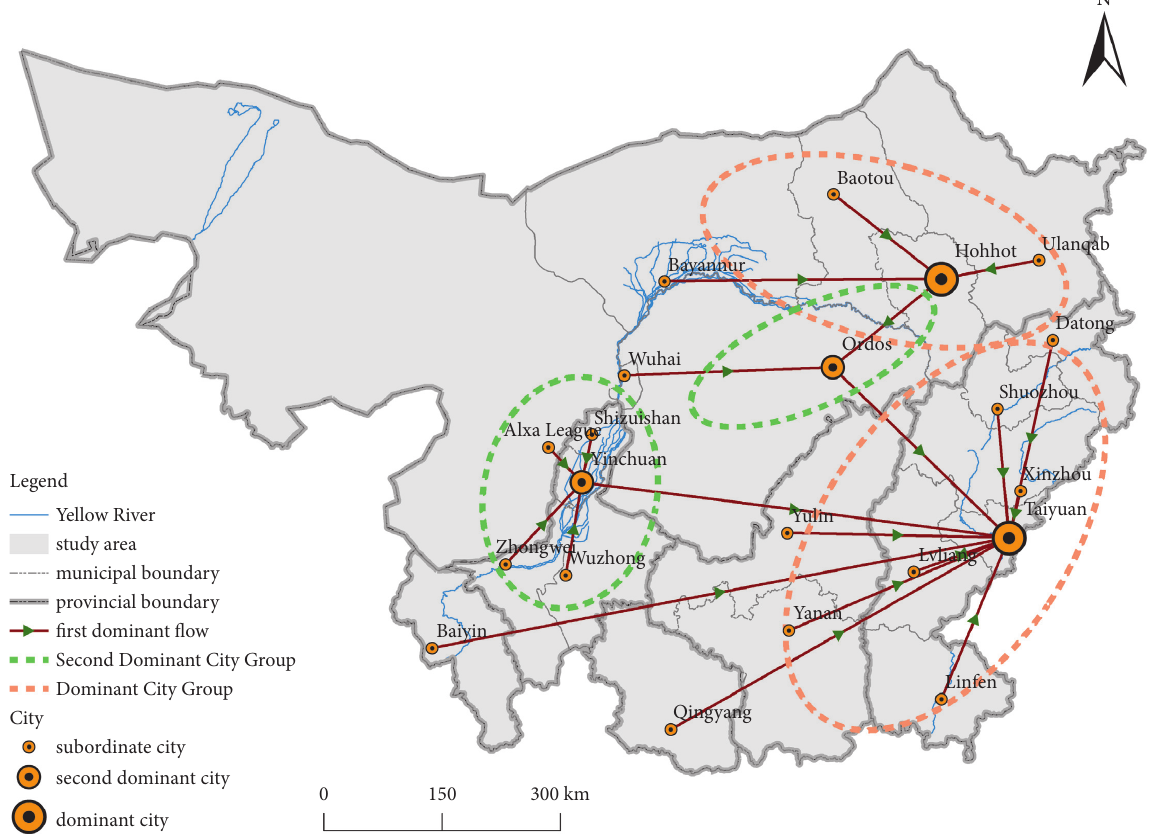
Figure 5: Spatial distribution of the first dominant flows in the